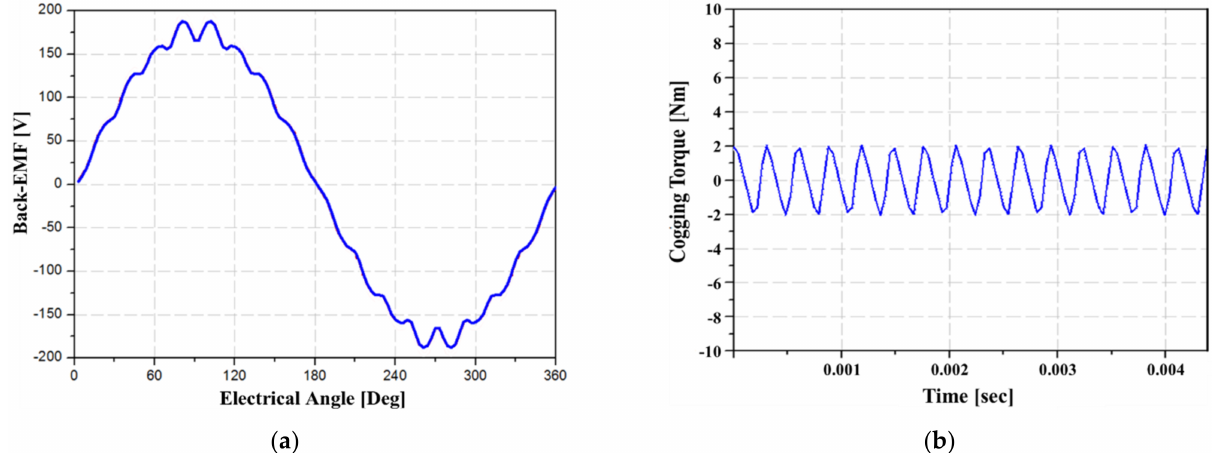
Figure 11. Design result of the base model in no-load condition: ( a ) back-EMF waveform; ( b ) cogging torque waveform.